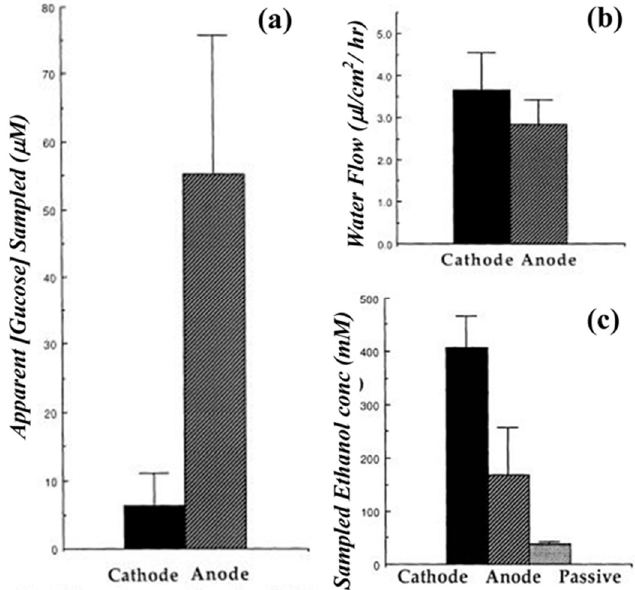
Figure 5. ( a ) Apparent extraction of glucose by reverse iontophoresis in 2 h. Reverse iontophoretic extraction of ( b ) titrated water and ( c ) 14 C-labeledethanol in 2 h [20].